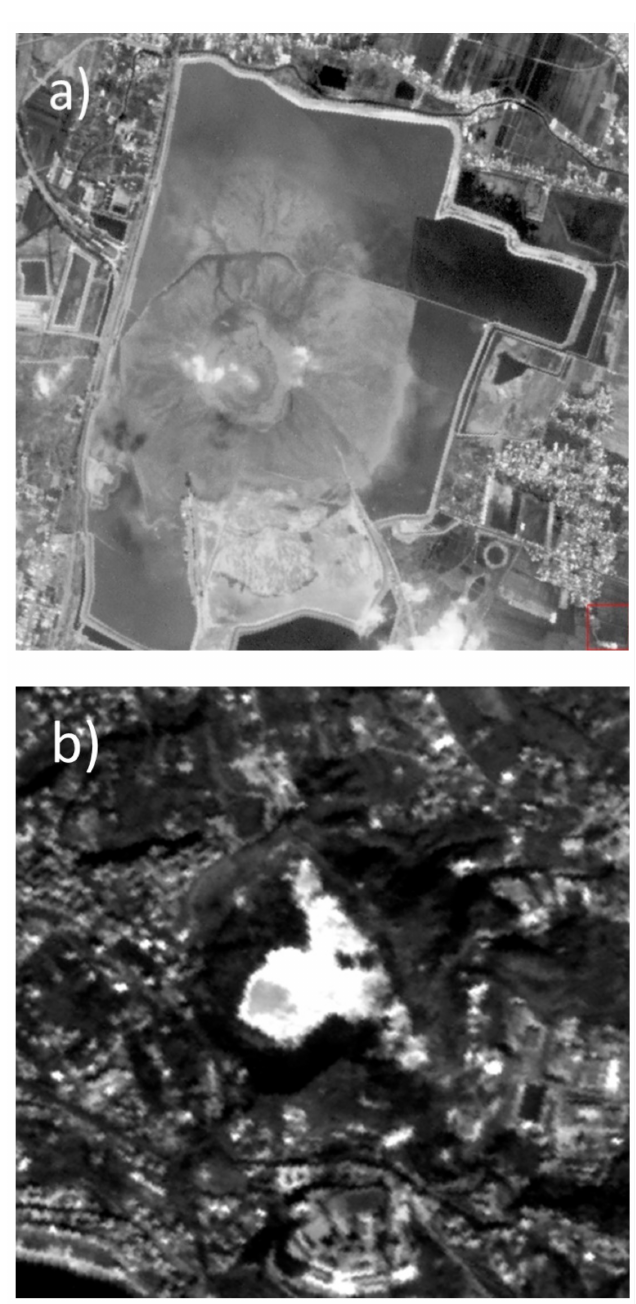
Figure 6. PRISMA panchromatic images of LUSI ( a ) and Solfatara ( b ) test